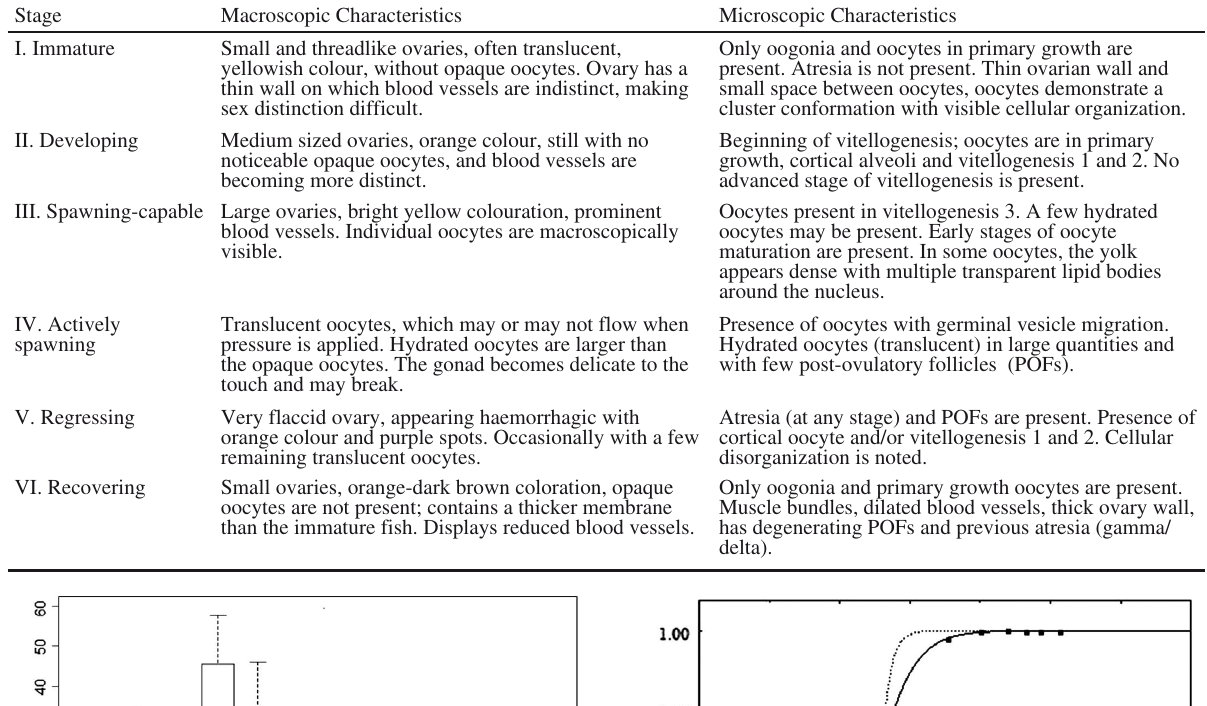
Table 5. – Macroscopic and microscopic characterization of the maturity phases of the ovaries of Coryphaena hippurus in the Saint Peter and Saint Paul Archipelago, adapted from Hunter et al. (1985), Murua et al. (2003) and Brown-Peterson et al. (2011).